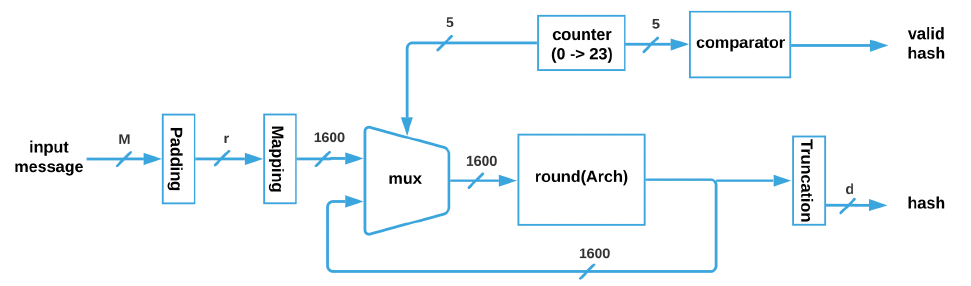
Figure 5. SHA-3 general